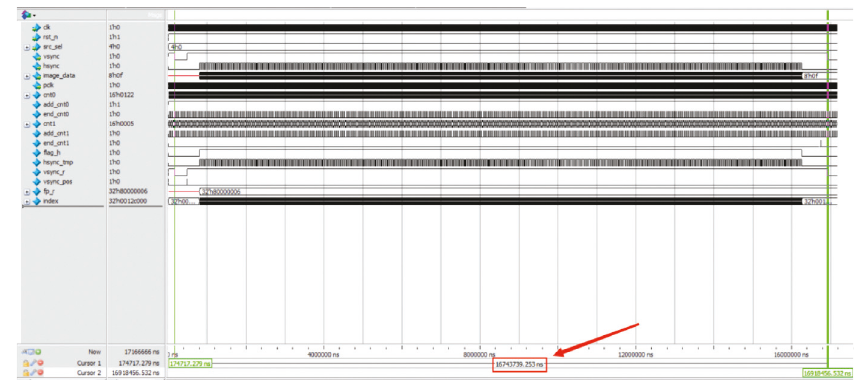
Figure 7: Simulation diagram of the video